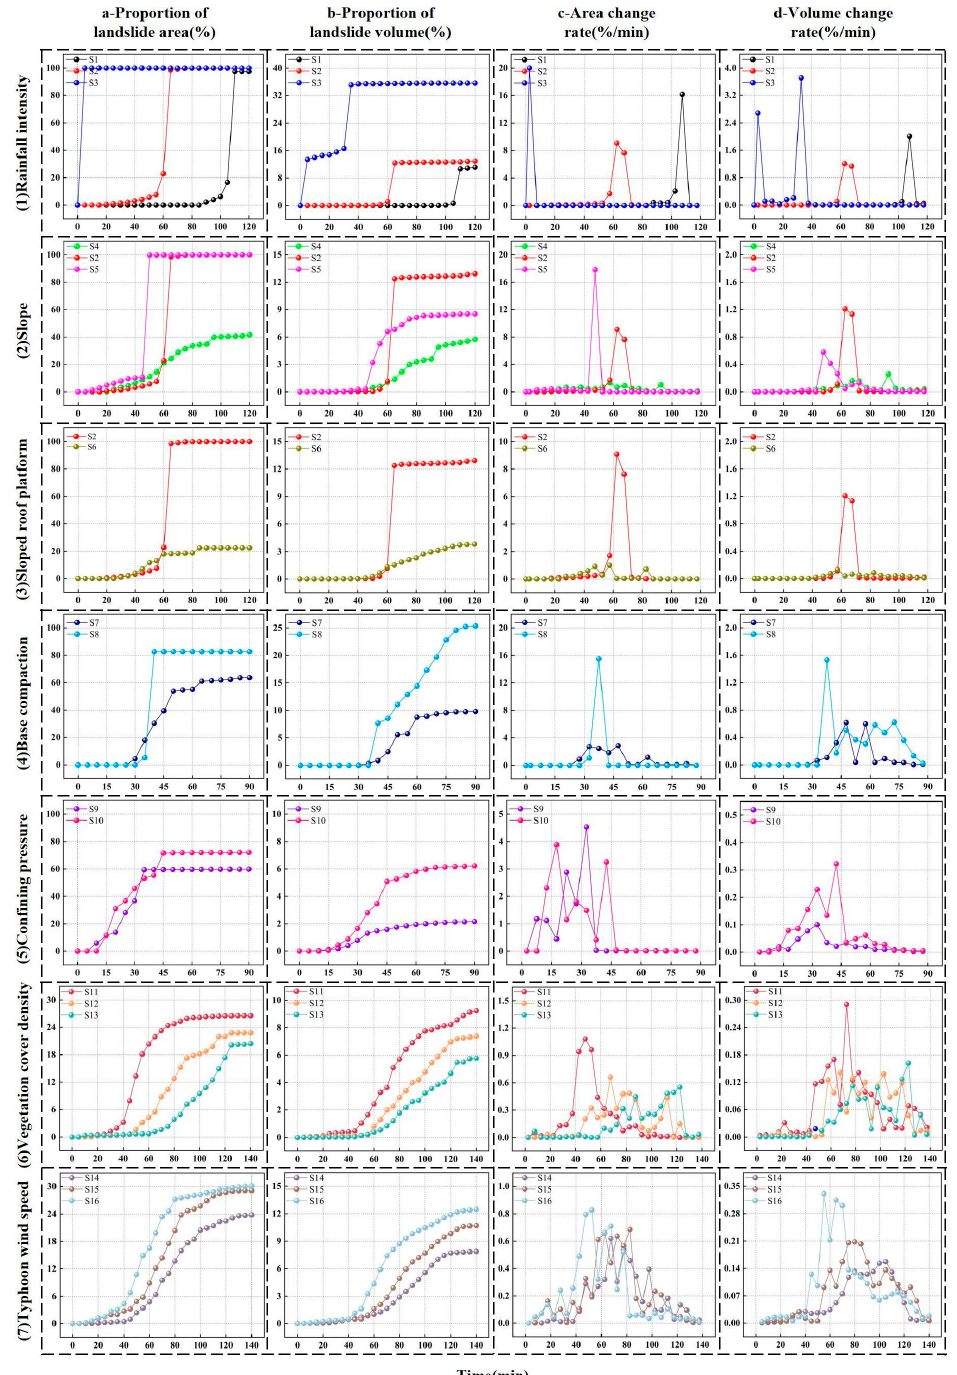
Figure 4. Quantitative identification curves of landslide: ( a ) represents the cumulative area percentage curve, ( b ) represents the cumulative volume percentage curve, ( c ) represents the area change rate curve, and ( d ) represents the volume change rate curve.